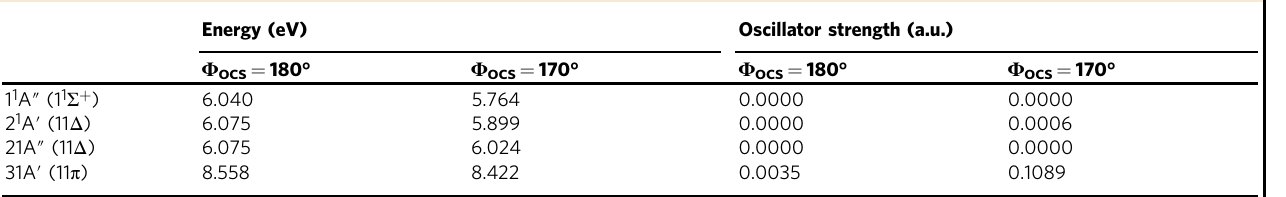
Table 2 Summary of quantum chemistry OCS